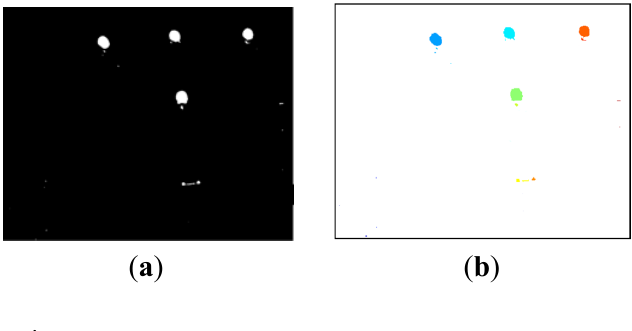
Figure 3. ( a ) Binarized image. ( b ) Labeled